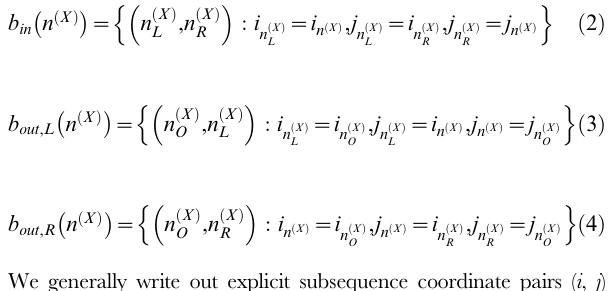
algorithm. The subroutines calcTransEmitProb, calcLBifurcProb and calcRBifurcProb used in the Inside algorithm are defined